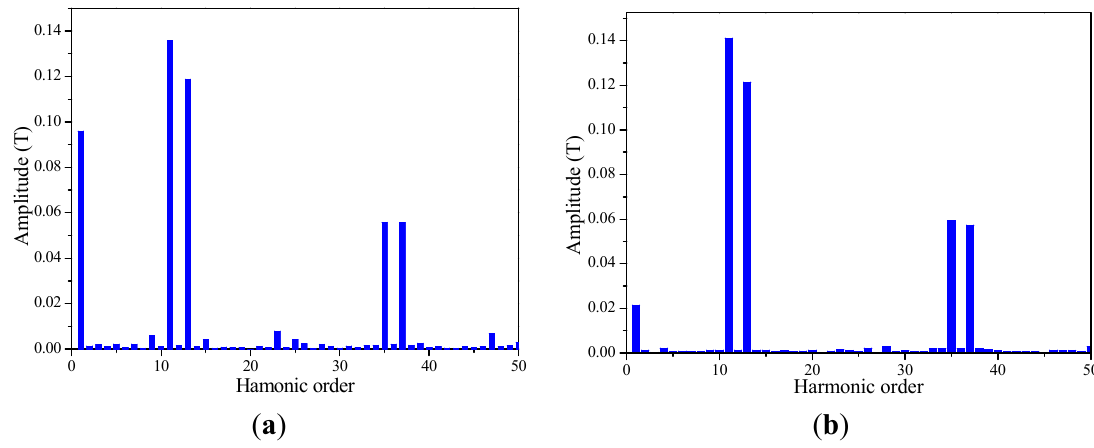
Figure 6. Air-gap flux density harmonic analysis of 24-slot/22-pole PMSM: ( a ) Alternate teeth wound scheme; ( b ) All teeth wound